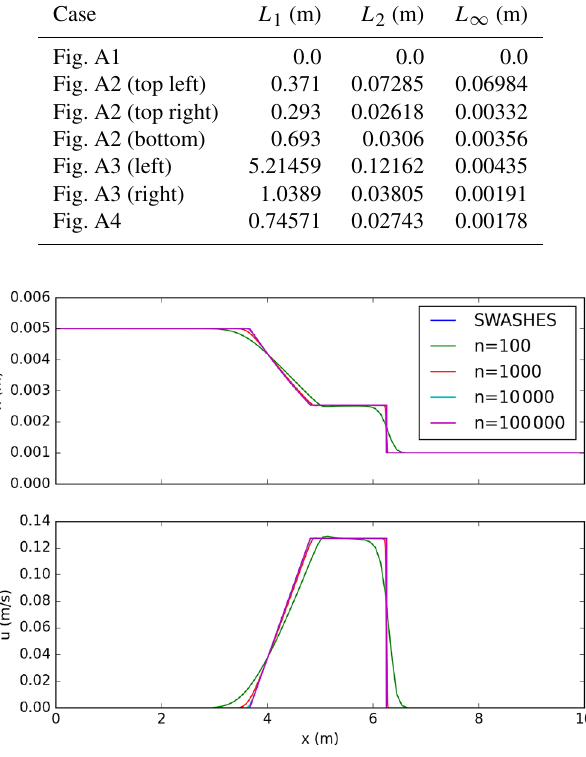
Figure A5. Dam break on wet bed without friction: model predic- tions for different number of grid cells. SERGHEI-SWE converges to the analytical solution (Stoker’s solution) as the grid is